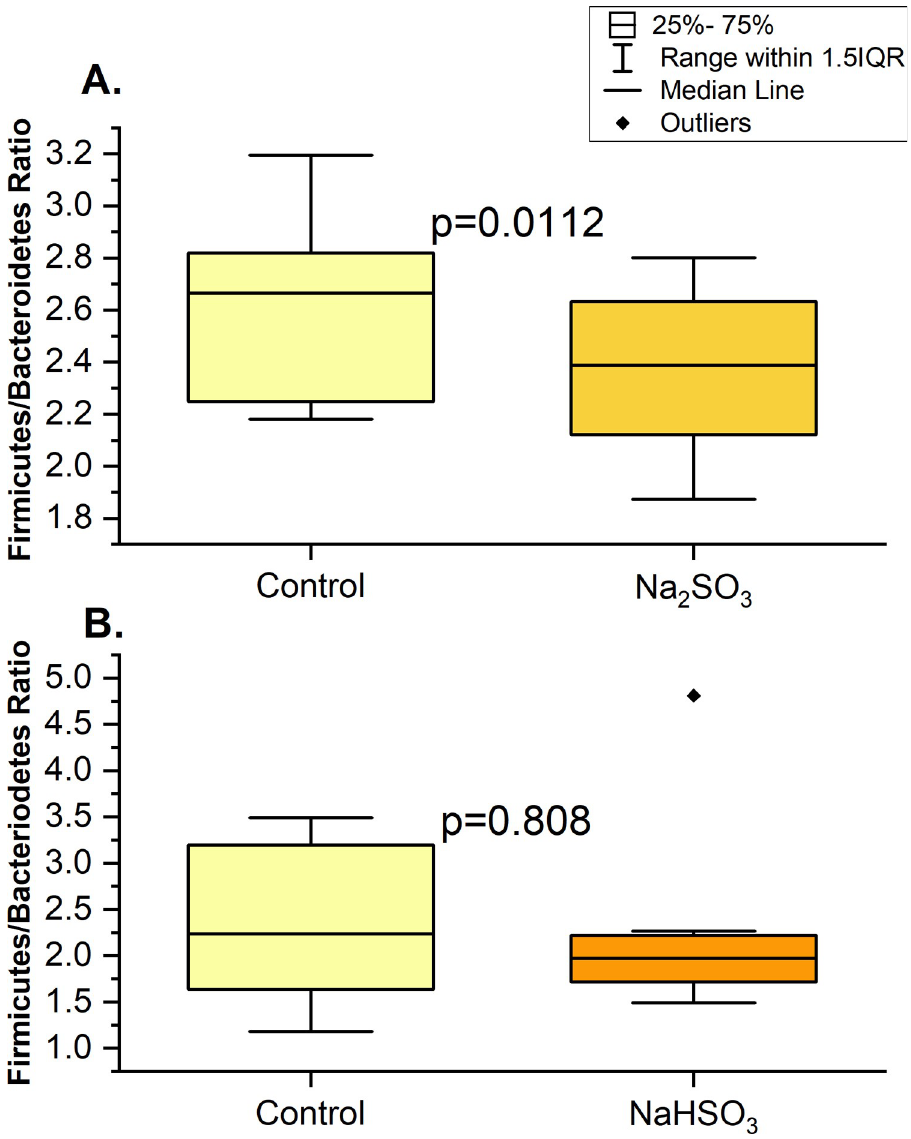
Fig 5. Ratio of firmicutes/bacteroidetes changes in F2 samples with sulfite treatments at time 0. 16S rRNA sequencing was used to determine the ratio (based on % abundance) for control and treated samples with Na 2 SO 3 (A) or with NaHSO ₃ (B) of individual